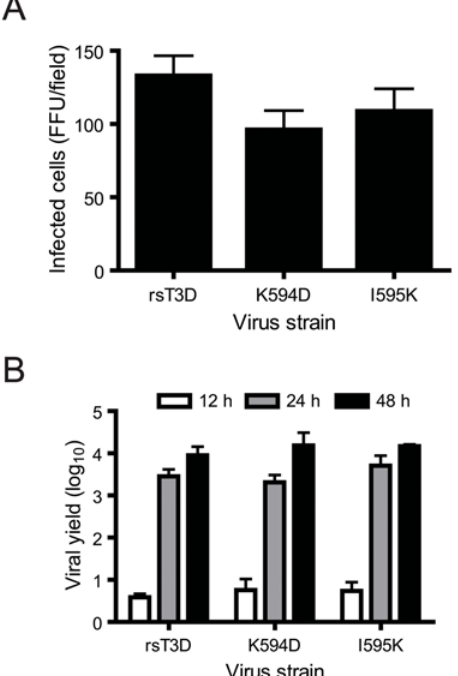
Figure 2. Infectivity and growth of m 1 Q mutants. (A) L929 cells were adsorbed with rsT3D or the indicated Q mutant at an MOI of 10 4 particles/cell. After incubation at 37 u C for 18 h, cells were fixed using methanol and visualized by immunostaining. Reovirus-infected cells were quantified by counting fluorescent cells. Results are expressed as mean fluorescent focus units (FFU) per field for triplicate samples. Error bars indicate SD. (B) L929 cells were adsorbed with rsT3D or the indicated Q mutant at an MOI of 2 PFU/cell. Titers of virus in cell lysates at the indicated intervals post-infection were determined by plaque assay. Results are expressed as viral yield for triplicate samples. Error bars indicate SD.